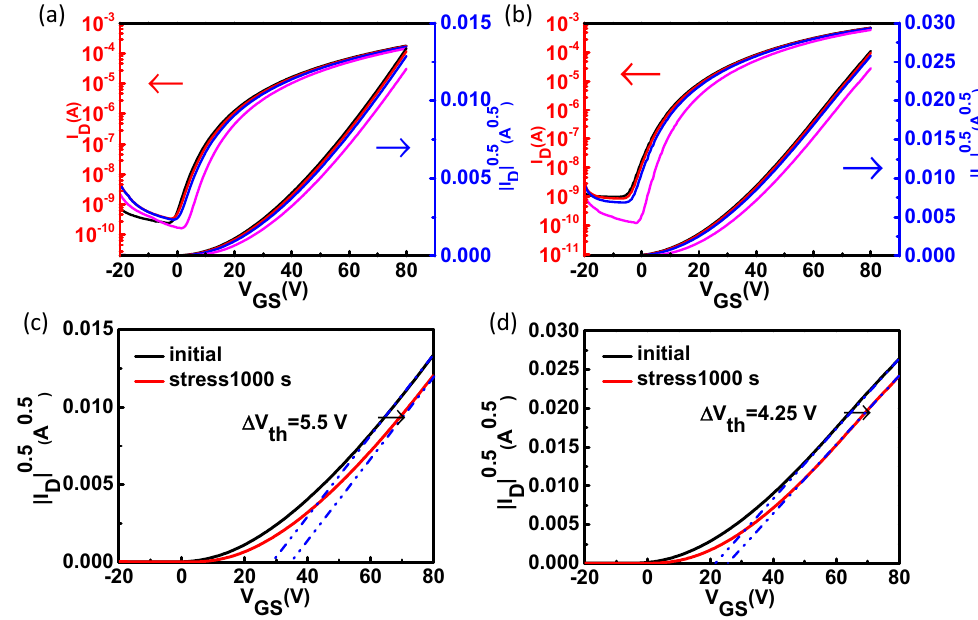
Figure 5. The bias stress stability of the pristine ZnO TFTs ( a ) and the ZnO TFTs with PCBA interfacial modification layers ( b ) with a gate bias of +20 V. (Black: initial; Red: stress10 s; Blue: stress100 s; Magenta: stress1000 s). The bias stress stability of the pristine ZnO TFTs ( c ) and the ZnO TFTs with PCBA interfacial modification layers ( d ) with a gate bias of +20 V for 1000 s.